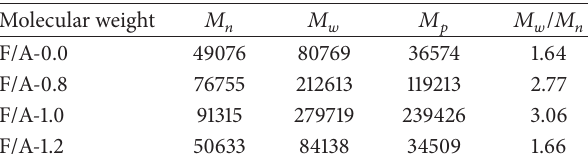
Figure 6: The molecular weight content of the modifier phase in the modified asphalt mortar. Table 5: The average molecular weights of the modifier after UV